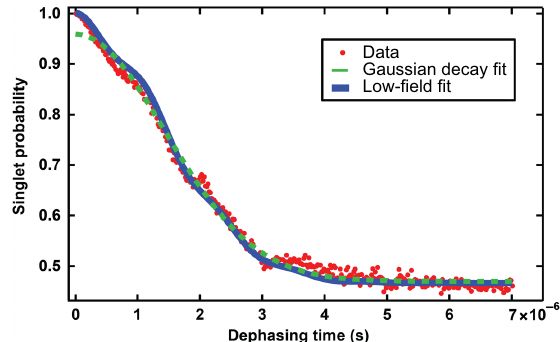
FIG. 10. Free induction decay taken at very small external magnetic field. The dashed green line is a fit to a Gaussian decay = 2.04 μ s. The solid blue line is a fit to curve, resulting in a T ∗ 2 = 1.98 μ s with a magnetic field of Eq. (A12) and results in a T ∗ 2 29.8 μ